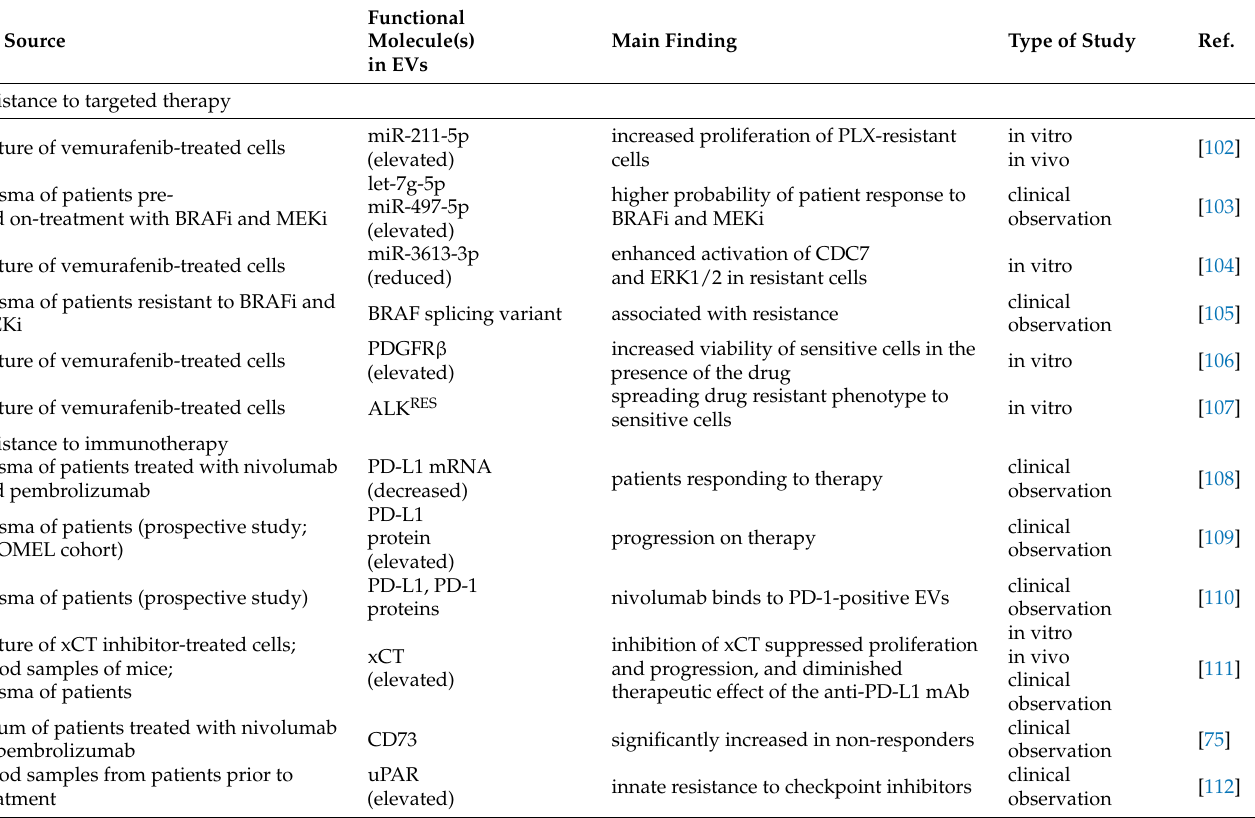
Table 1. The role of EVs in melanoma resistance to targeted therapy and immunotherapy with checkpoint